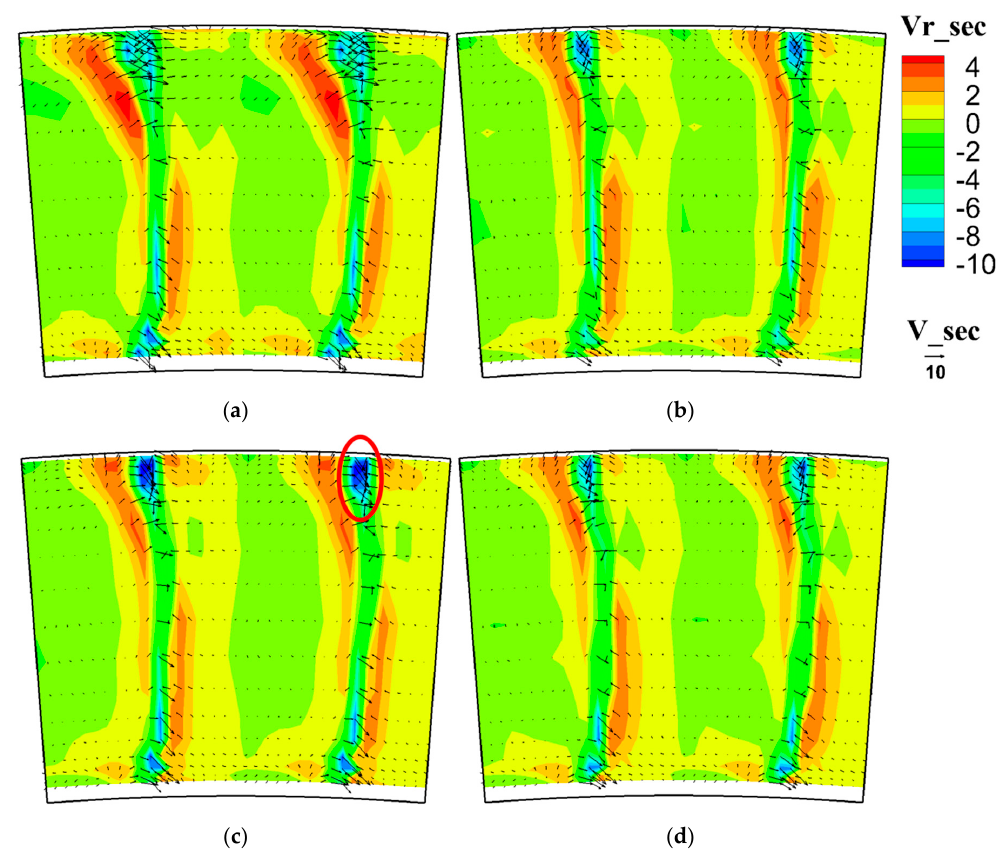
Figure 20. Secondary velocity contours with secondary velocity vectors (test results). ( a ) Axisymmetric stator; ( b ) scheme s1 ; ( c ) scheme s2 ; ( d ) scheme s5.